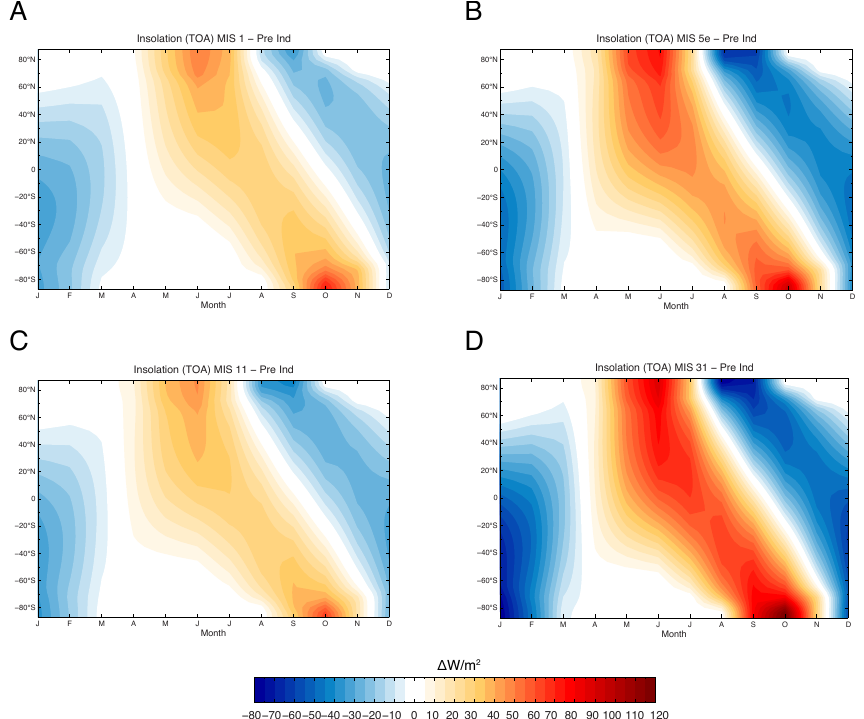
Figure 4. Monthly insolation anomalies at the top of the atmosphere for the interglacial intervals modeled here (Wm − 2 ). (a) MIS-1 anoma- lies with respect to preindustrial (modern) orbit, (b) MIS-5e anomalies with respect to preindustrial orbit, (c) MIS-11c anomalies with respect to preindustrial orbit and (d) MIS-31 anomalies with respect to preindustrial